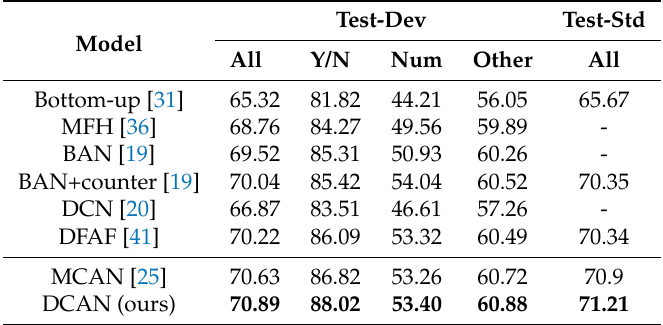
Table 3. Comparison with the state-of-the-art methods on the VQA-v2 dataset.